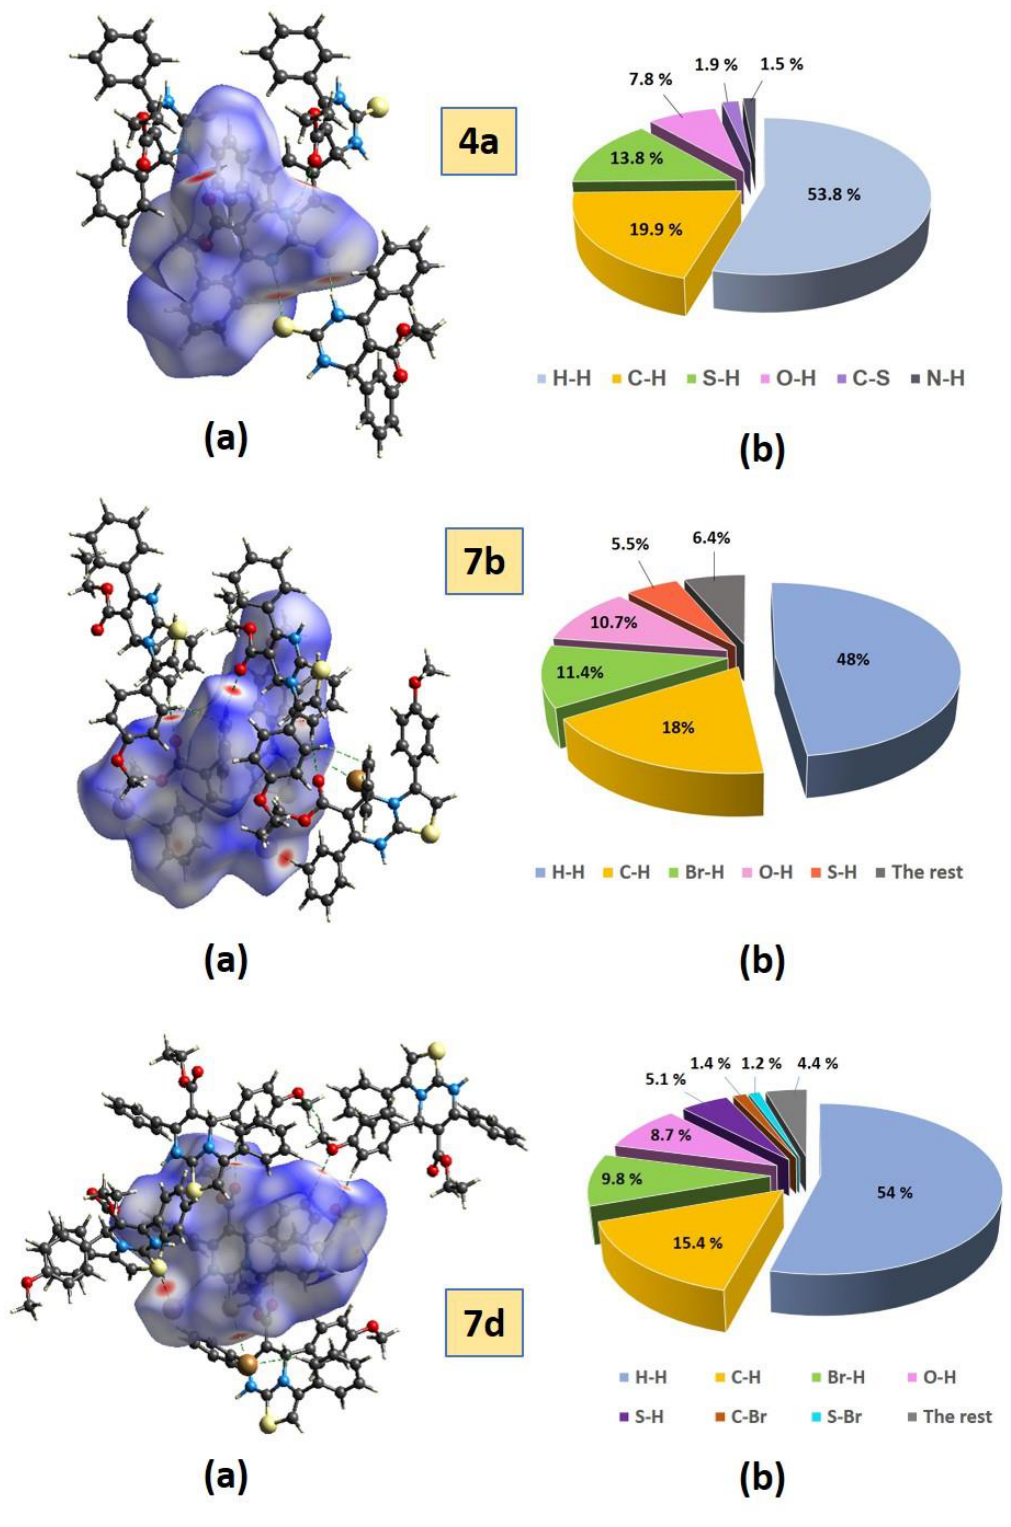
Figure 3. ( a ) 3D Hirshfeld surfaces mapped with d norm ; red colored regions show shorter contacts; ( b ) histograms showing the percentage contributions of the various types of interactions predicted for compounds 4a , 7b , and